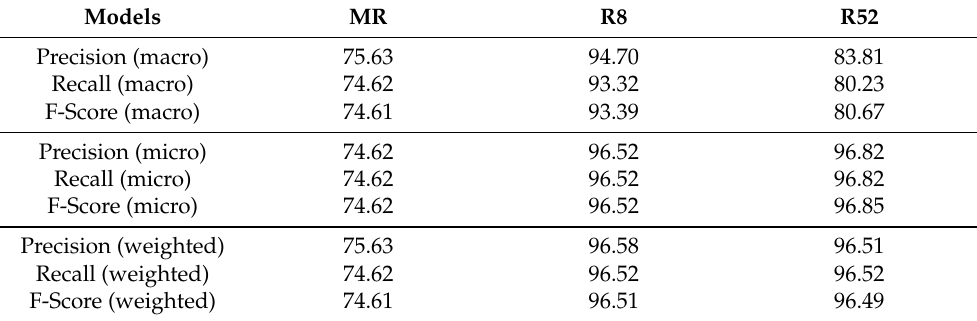
Table 6. Performance of TM+Bi-GRU+Attn for various evaluation